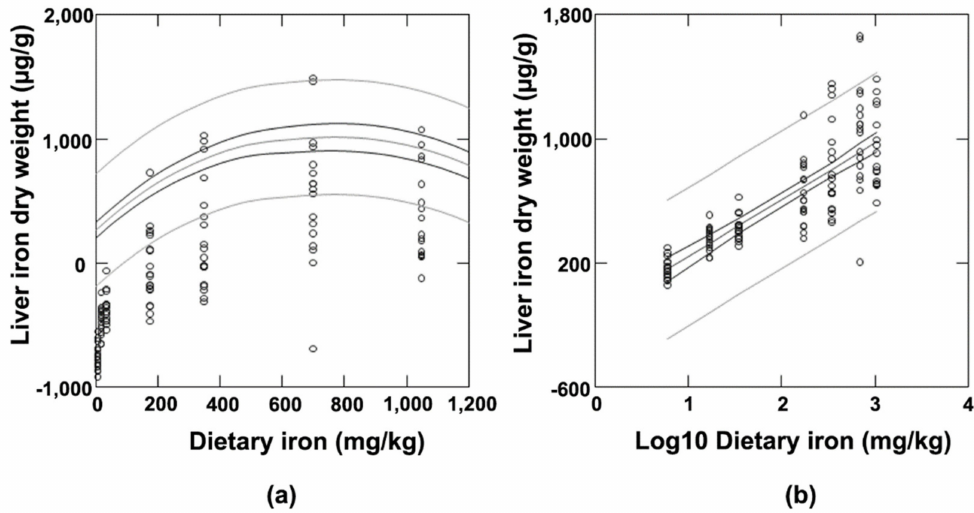
Figure 1. Iron regression analysis. ( a ) Polynomial regression analysis, r2 = 0.062, p < 0.001. For the linear component, p < 0.001; for the quadratic component, p = 0.001; for the cubic component, p = 0.047. ( b ) Linear regression, r2 = 0.062, p <